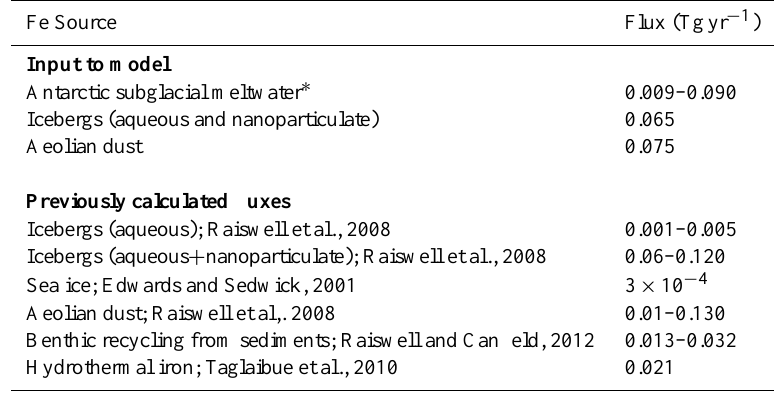
Table 1. Annual iron fluxes modelled in this paper for aeolian dust, icebergs and subglacial meltwater and in comparison to previously calculated values for these and other hypothesised iron sources to the Southern